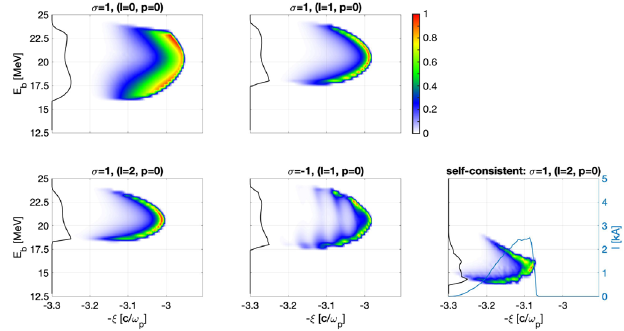
FIG. 5. Longitudinal phase space of the injected beams at ω t ¼ 31 . The charge density is normalized to its peak in each p subplot. The black lines are the energy spectrum. The blue line in the self-consistent case (bottom right) shows the current profile.